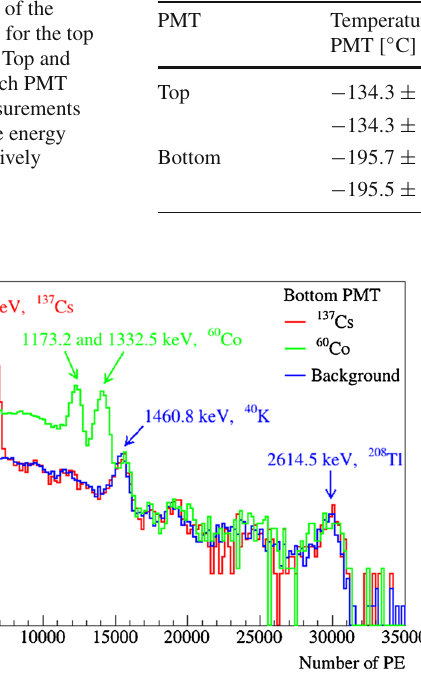
Fig. 7 Energy spectra of the bottom PMT at 80 K with a source attached. The digitizer was triggered when both PMTs recorded a pulse above a certain threshold within a time window of 16 ns. The trigger logic is shown in the right flow chart in Fig. 3. The trigger rate for the background, 137 Cs and 60 Co data taking was 100 Hz, 410 Hz and 520 Hz, respectively, if the threshold was set to 10 ADC counts above the pedestal level.